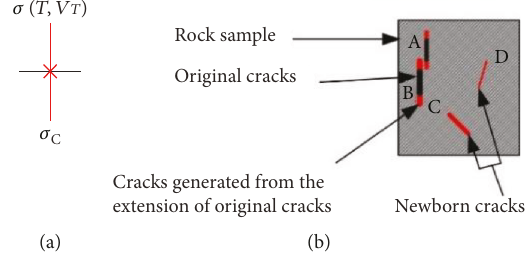
Figure 11: Cracks generated by thermal stress: (a) diagram of stress equilibrium; (b) cracks in the rock sample.